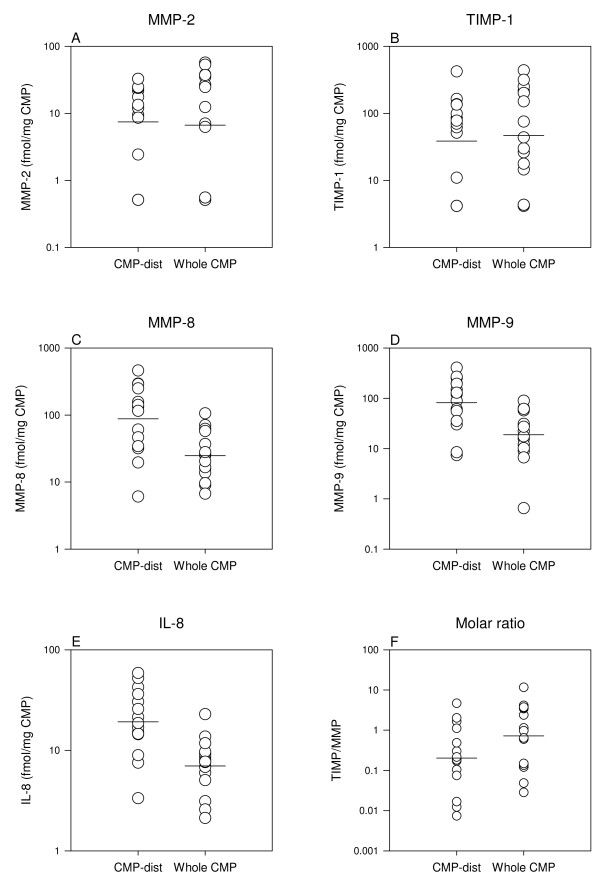
Plug compartment. Comparisons of concentrations and the molar TIMP/MMP ratios in the term CMP-dists (n = 15) and the term whole CMPs (n = 15). Results from Students t-test are listed in Table 3. Note the log-scale.